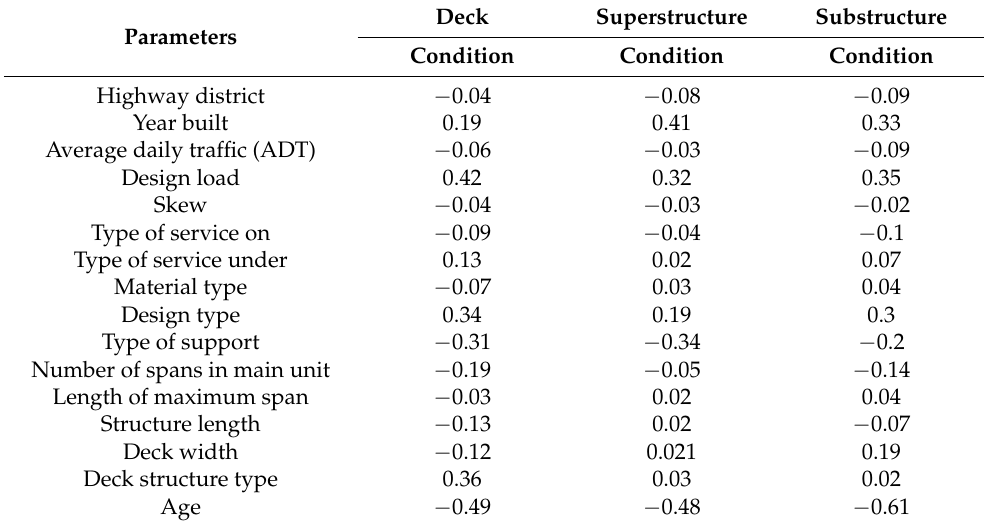
Table 4. Correlation coefficient